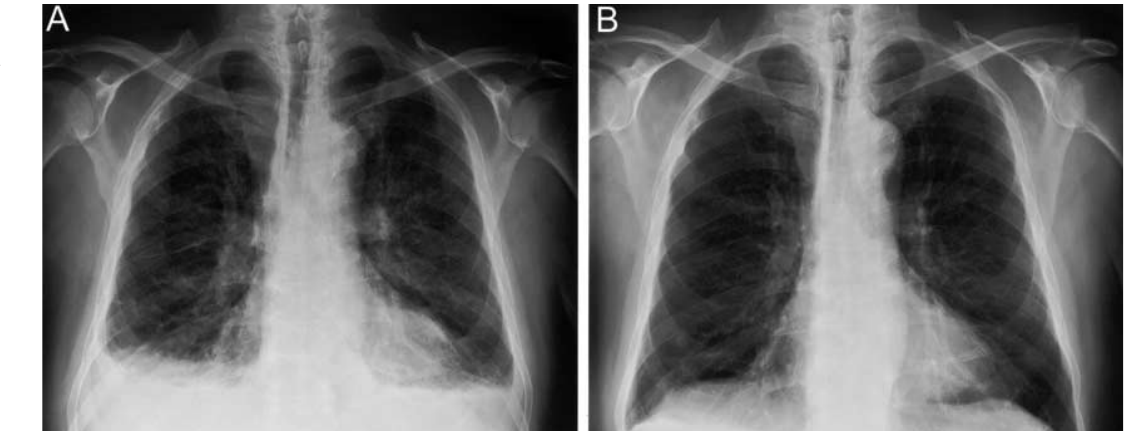
A, B: Chest X-ray of case 2 showing bilat- eral reticulo-nodular interstitial infiltrates, also visible on the lateral chest radiograph. Known previous right upper lobe resection. C and D: Regression of the bilateral